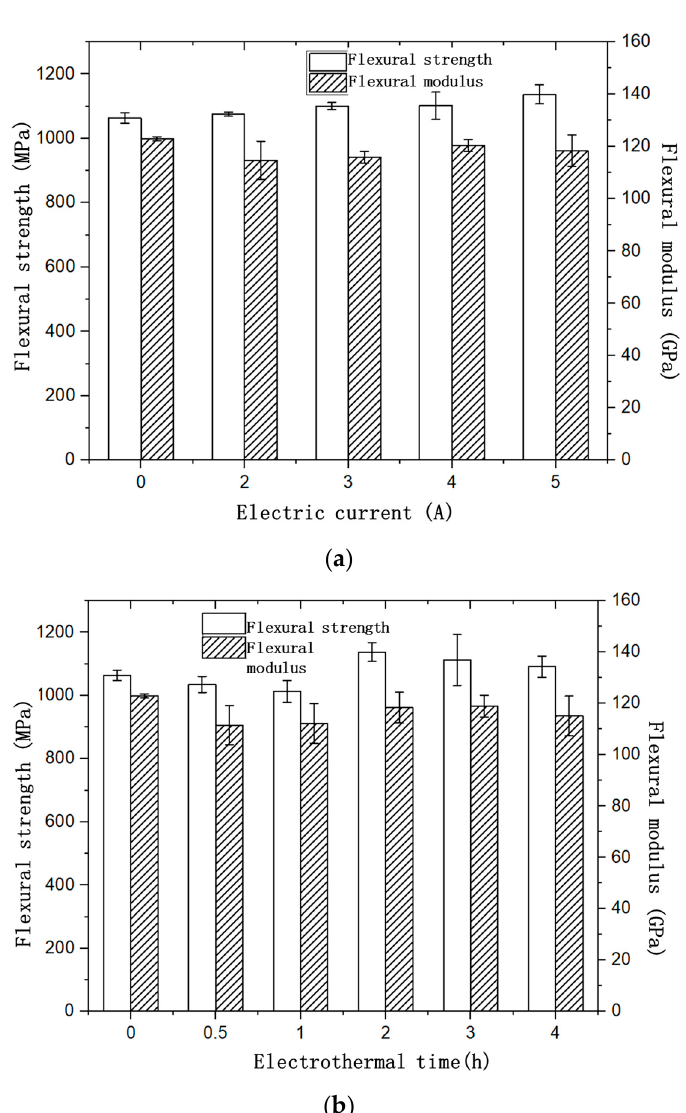
Figure 7. The relationship between the flexural performance of CFRE plate and conduction time and current. ( a ) The relationship between the conduction time and the flexural strength and modulus of the material with the current loading time of 2 h. ( b ) The relationship between the flexural strength and modulus of the material and the conduction current under